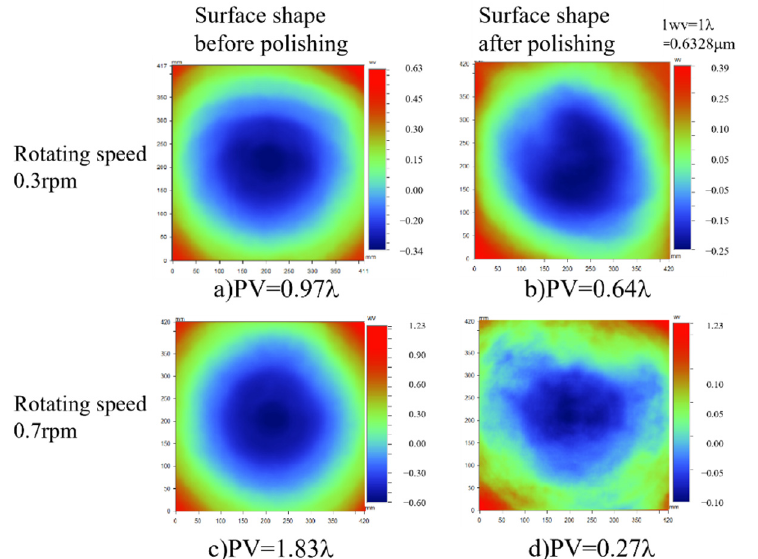
Figure 13. Experiment of influence law of rotating speed on element surface shape. ( a ) Rotating speed is 0.3 rpm before polishing, ( b ) rotating speed is 0.3 rpm after polishing, ( c ) rotating speed is 0.7 rpm before polishing and ( d ) rotating speed is 0.7 rpm after polishing.